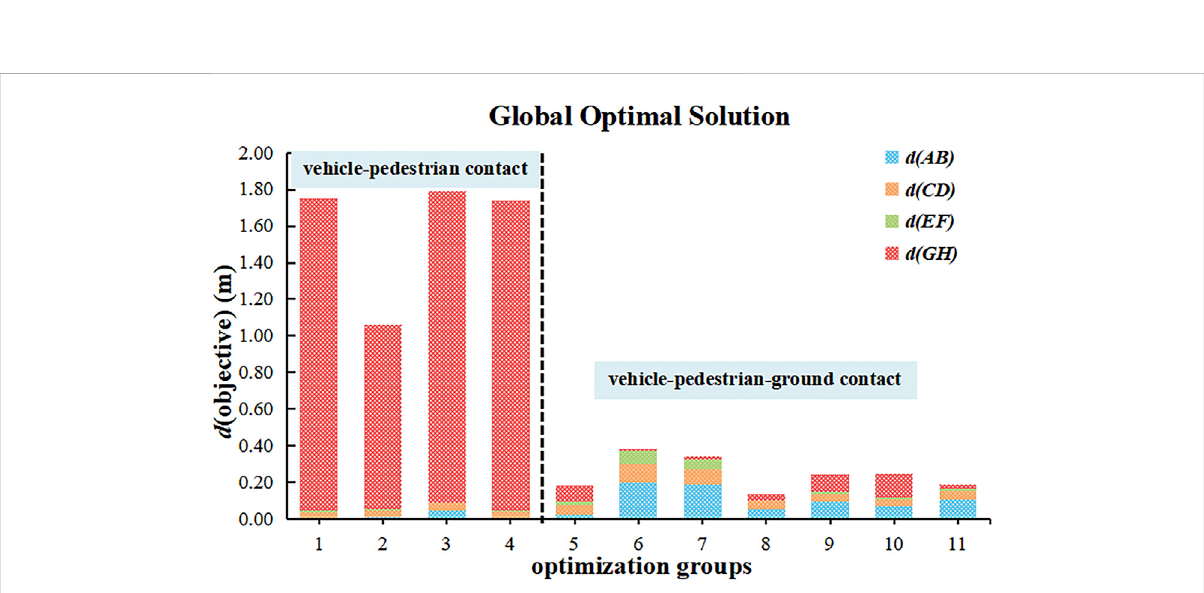
FIGURE 10 Achieved distances after optimization between model positions and observed positions of the global optimal solutions for the 11 optimization